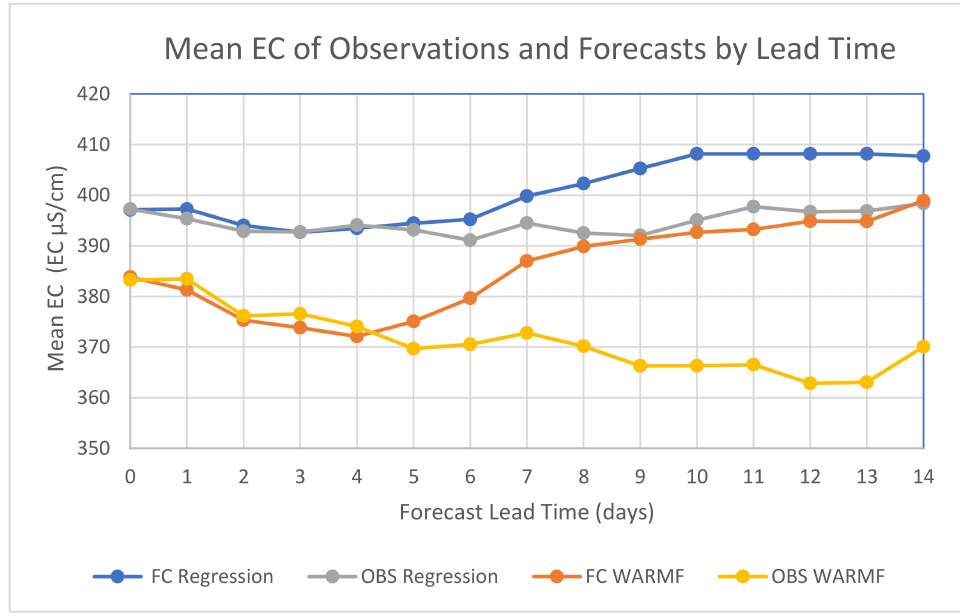
Figure 5. Means of the observed (OBS) EC and Forecast (FC) EC for the Regression and WARMF models for all forecast lead times between 22 February 2018 and 22 May